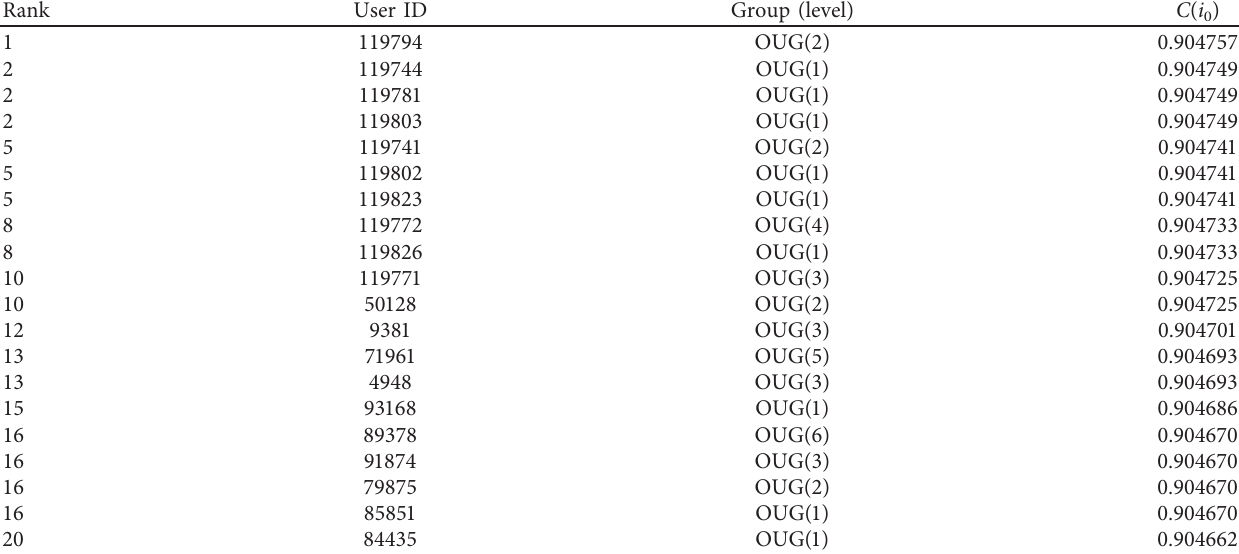
Table 8: Top 20 P10/P10 Plus